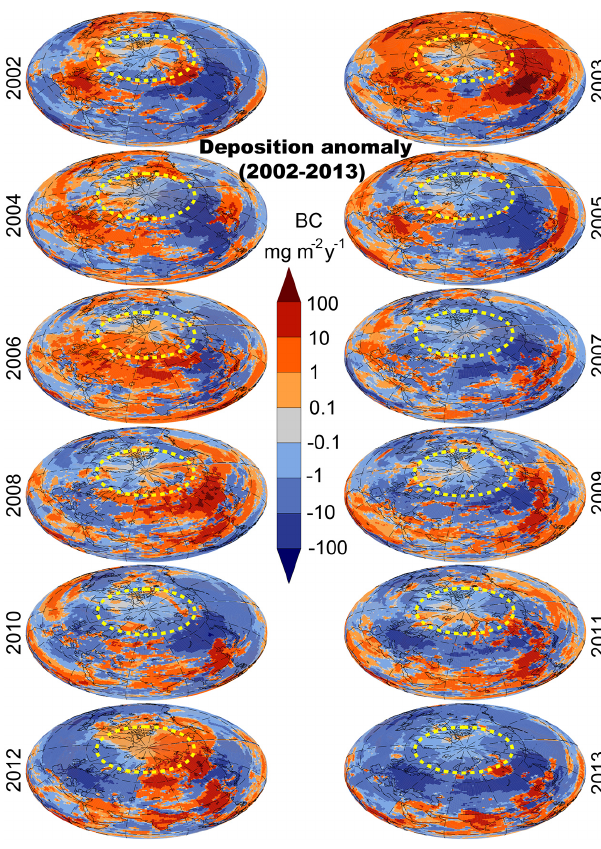
Figure 1. Deposition anomalies of BC (mgm − 2 yr − 1 ) in the North- ern Hemisphere for the period 2002–2013 from our combined simu- lation (FEI-NE + MACCity) in northern Eurasia. The dashed yellow line represents the border of the Arctic ( ∼ 67 ◦ N). Note that the most intense years were estimated to be 2003, 2006, 2008, and 2012.